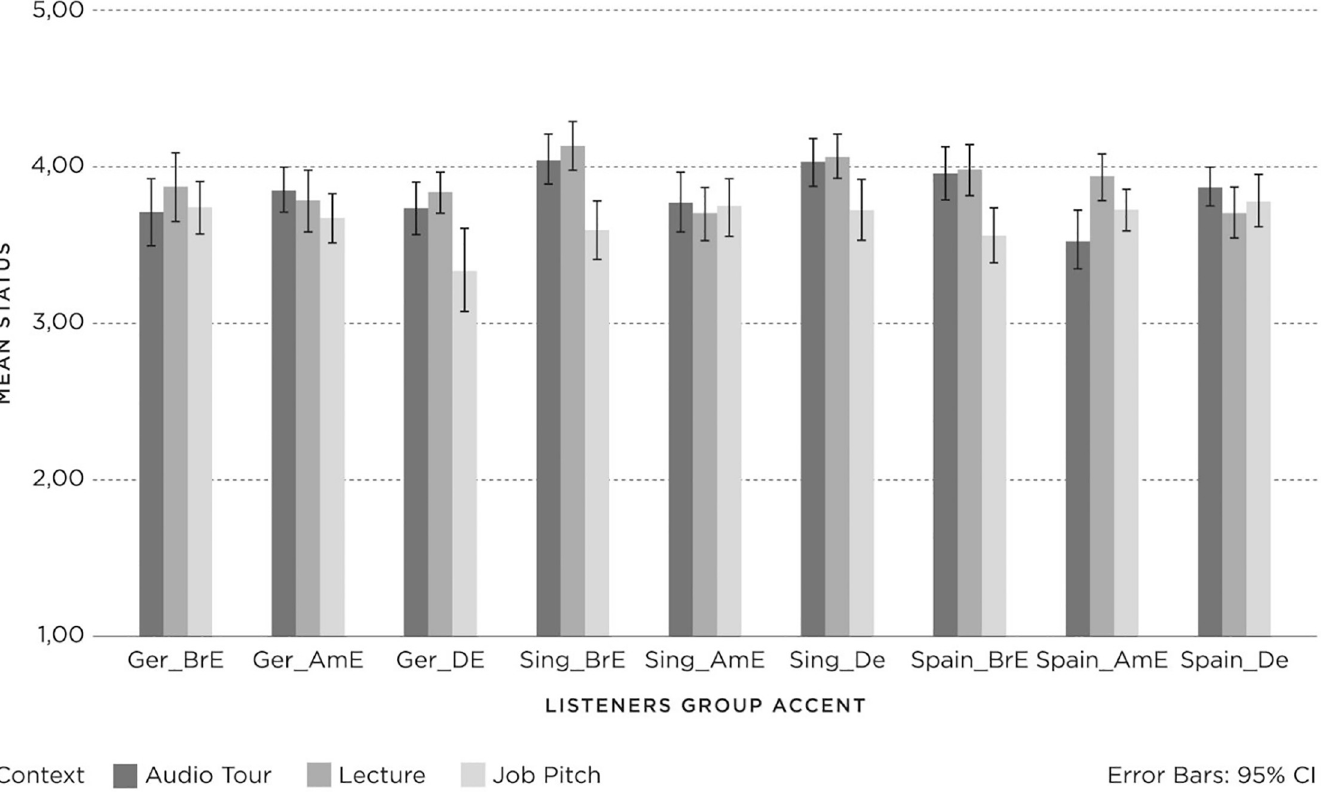
Fig 5. Status (1 = negative; 3 = neutral; 5 = positive) for Listener groups (Germany (Ger), Spain, Singapore (Sing)) per accent (British English (BrE), American English (AmE), Dutch English (DE)) and context (Audio Tour, Lecture, Job